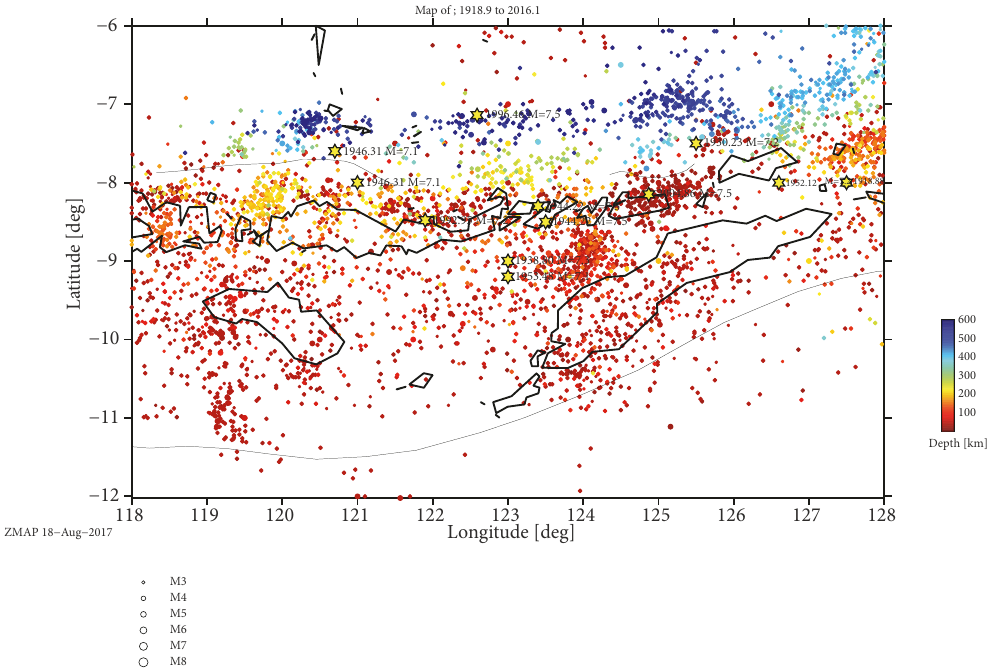
Figure 4: Earthquake seismicity map in ENTP showing depth and magnitude using ZMAP 6.0.